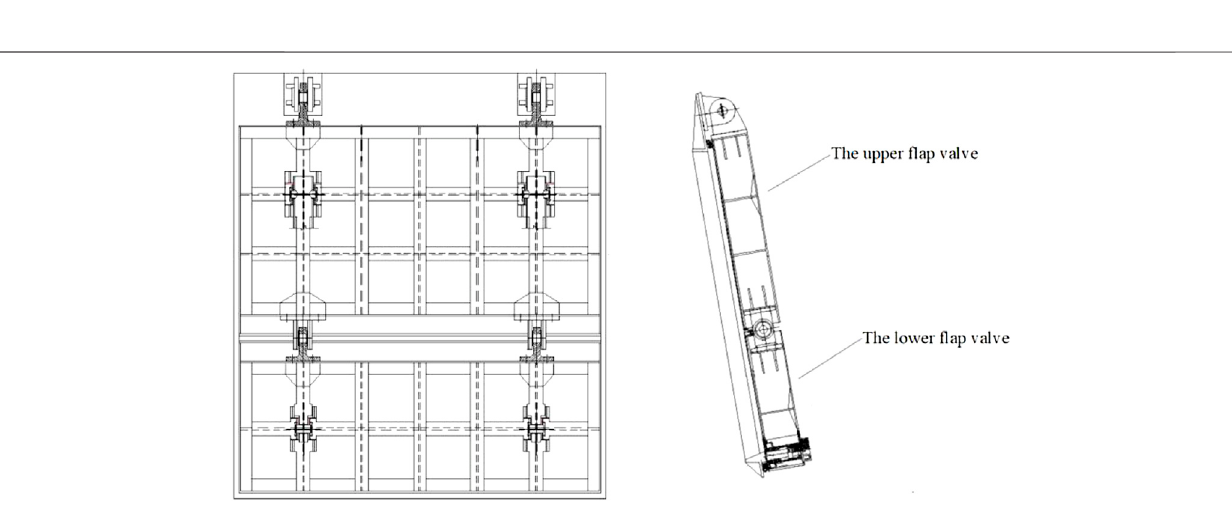
FIGURE 2 | Structure diagram of the double-stage fl ap